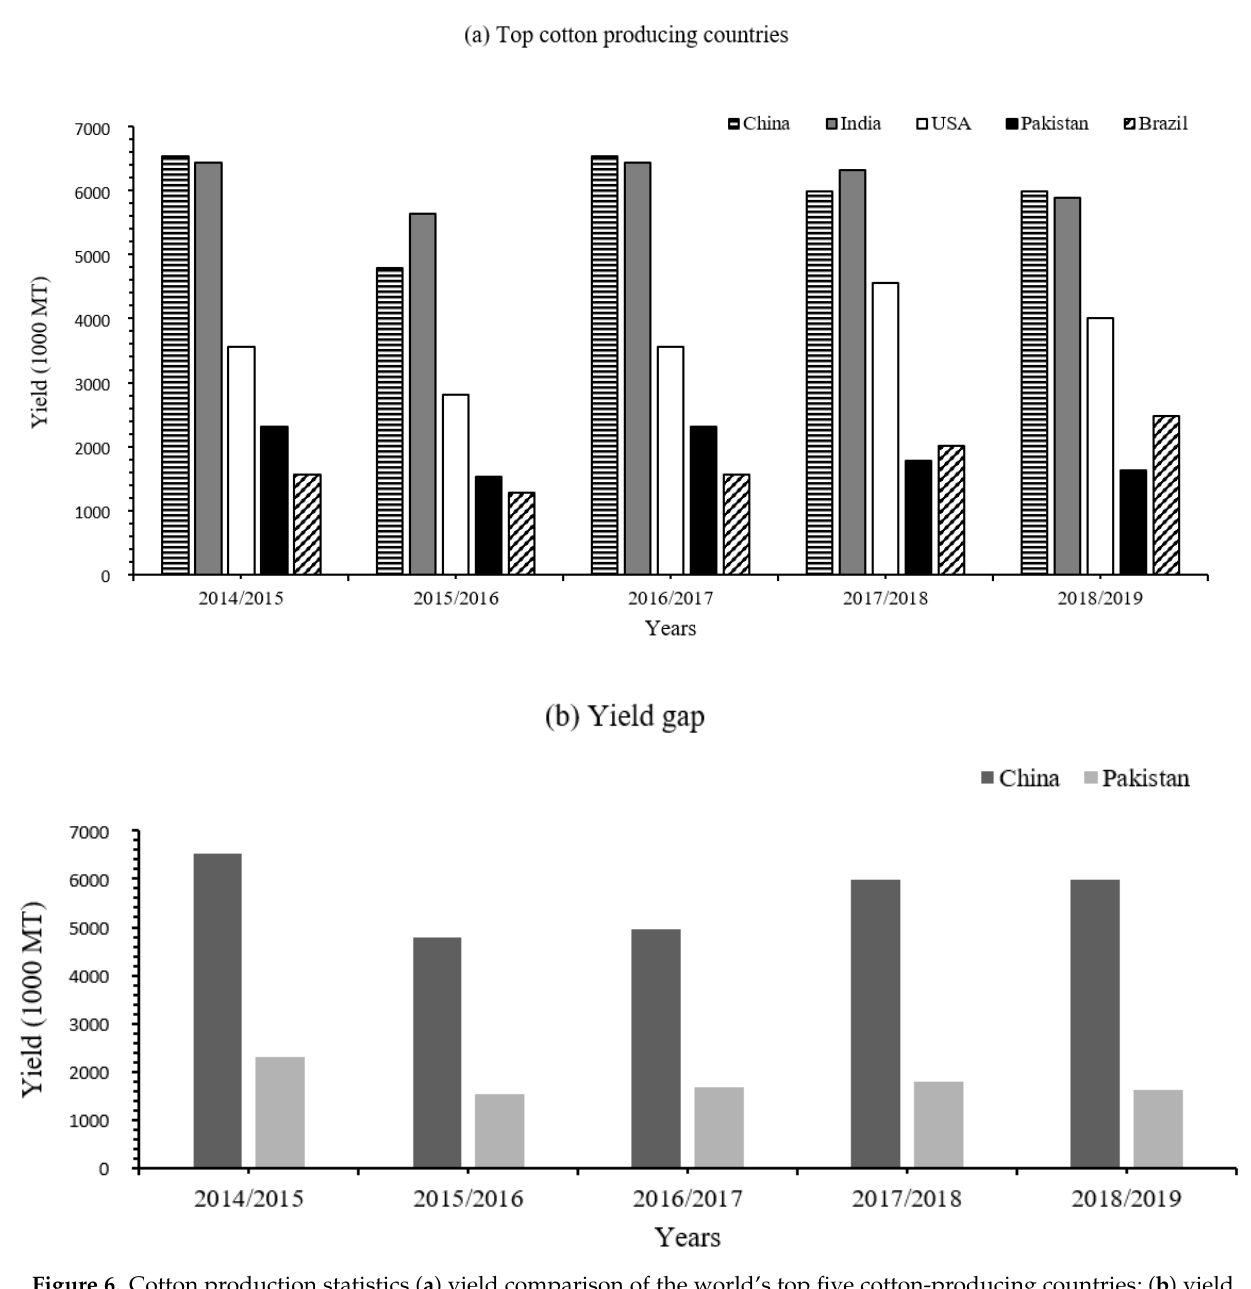
Figure 6. Cotton production statistics ( a ) yield comparison of the world’s top five cotton-producing countries; ( b ) yield comparison of Pak-China cotton production during 2014–2019 (1000 MT), where the model predicts 2018/19